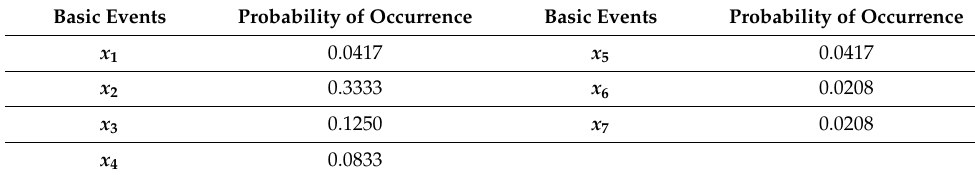
Table 4. Probability of occurrence of basic